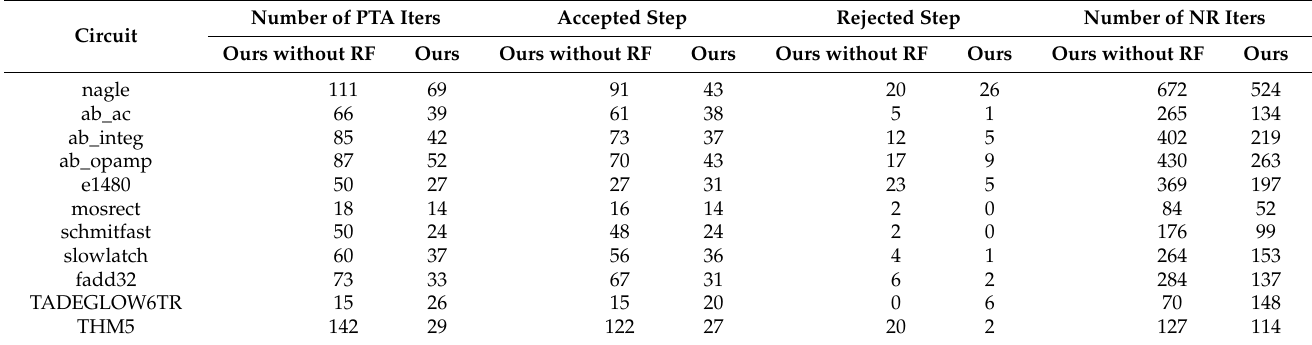
Table 6. Verify the effectiveness of feature selection based on a random forest.